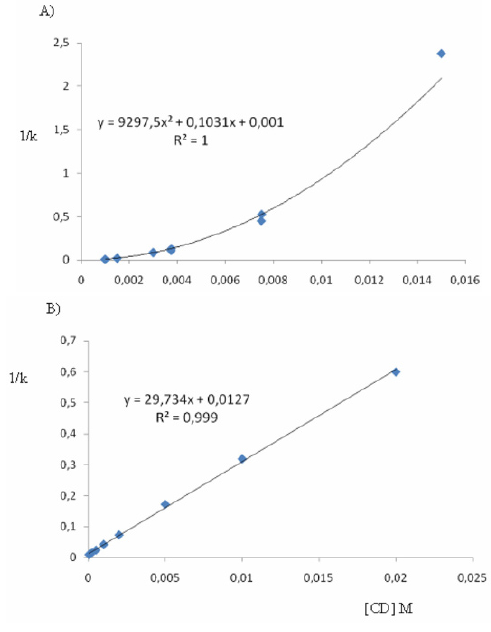
Figure 2. Dependence of the reciprocal of the retention factor (1/k ) versus CD concentration (M) giving the complex stoichiometry and stability constants; parabolic for 1:2 stoichiometry for the complex with β -CD (A) and linear for the 1:1 γ -CD complex stoichiometry (B).